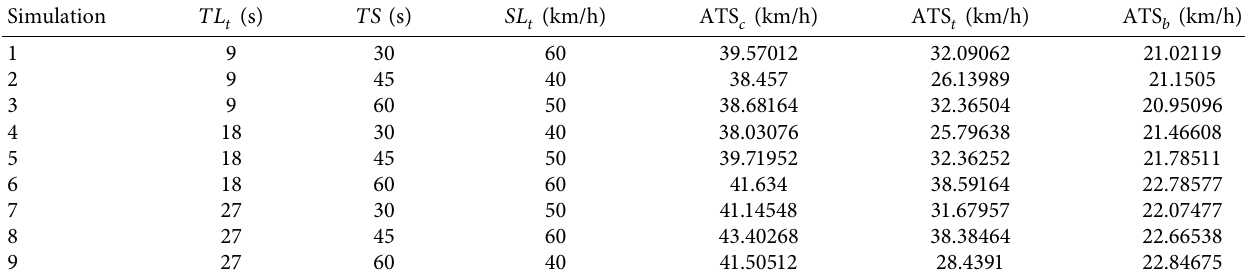
Table 3: Experiment 2 simulations.